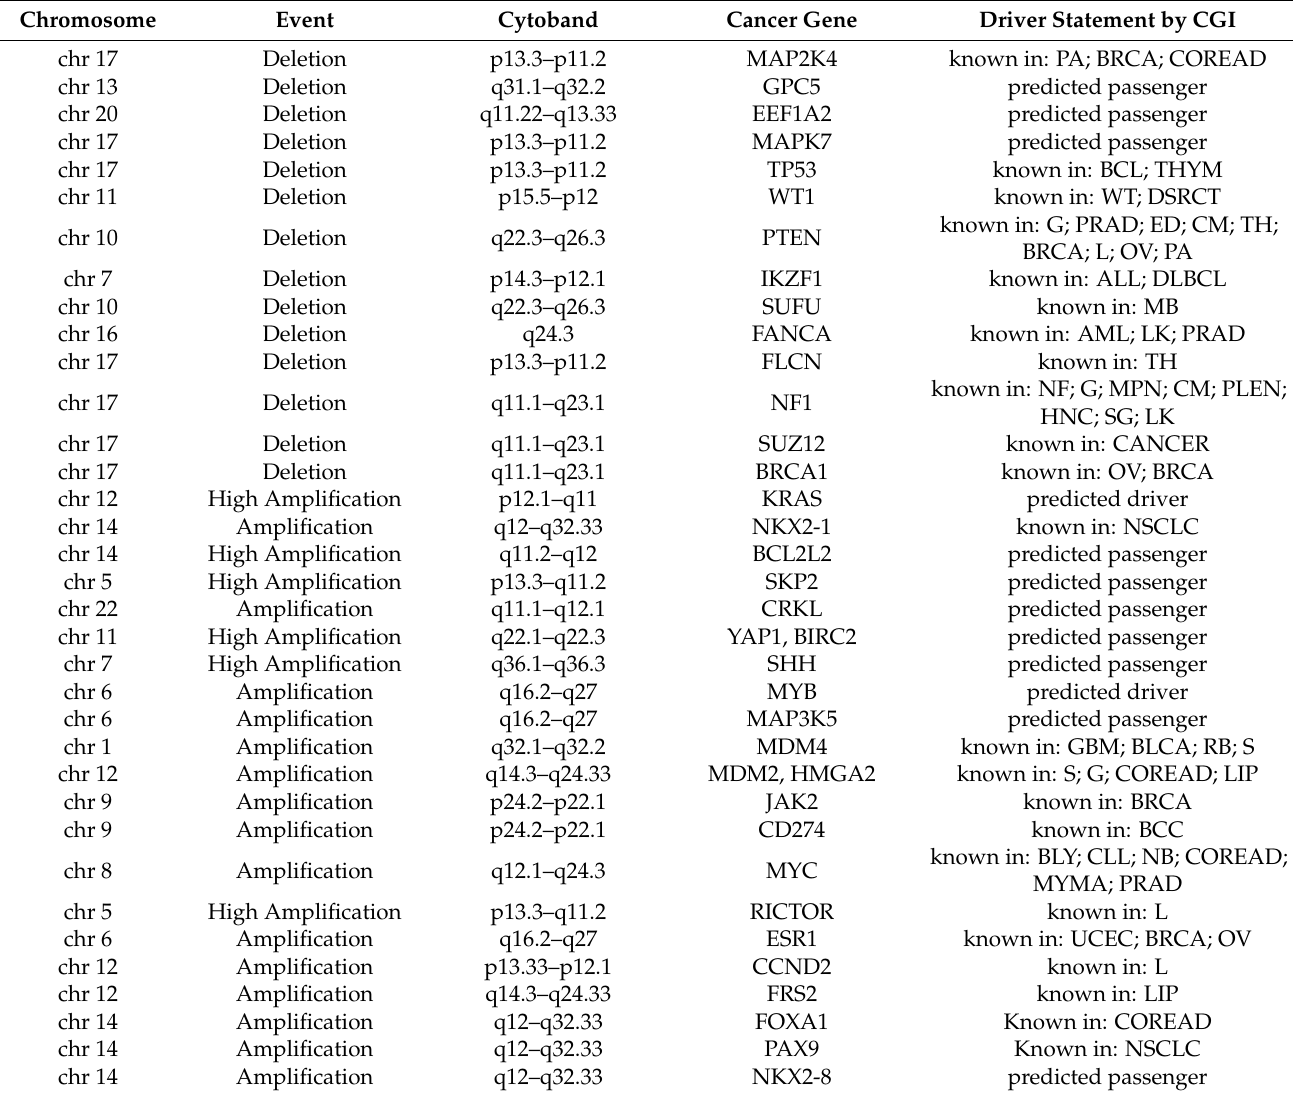
Table 1. Copy number alterations differentially found in FaDu resistant compared with FaDu parental cell line by whole exome sequencing and Nanostring